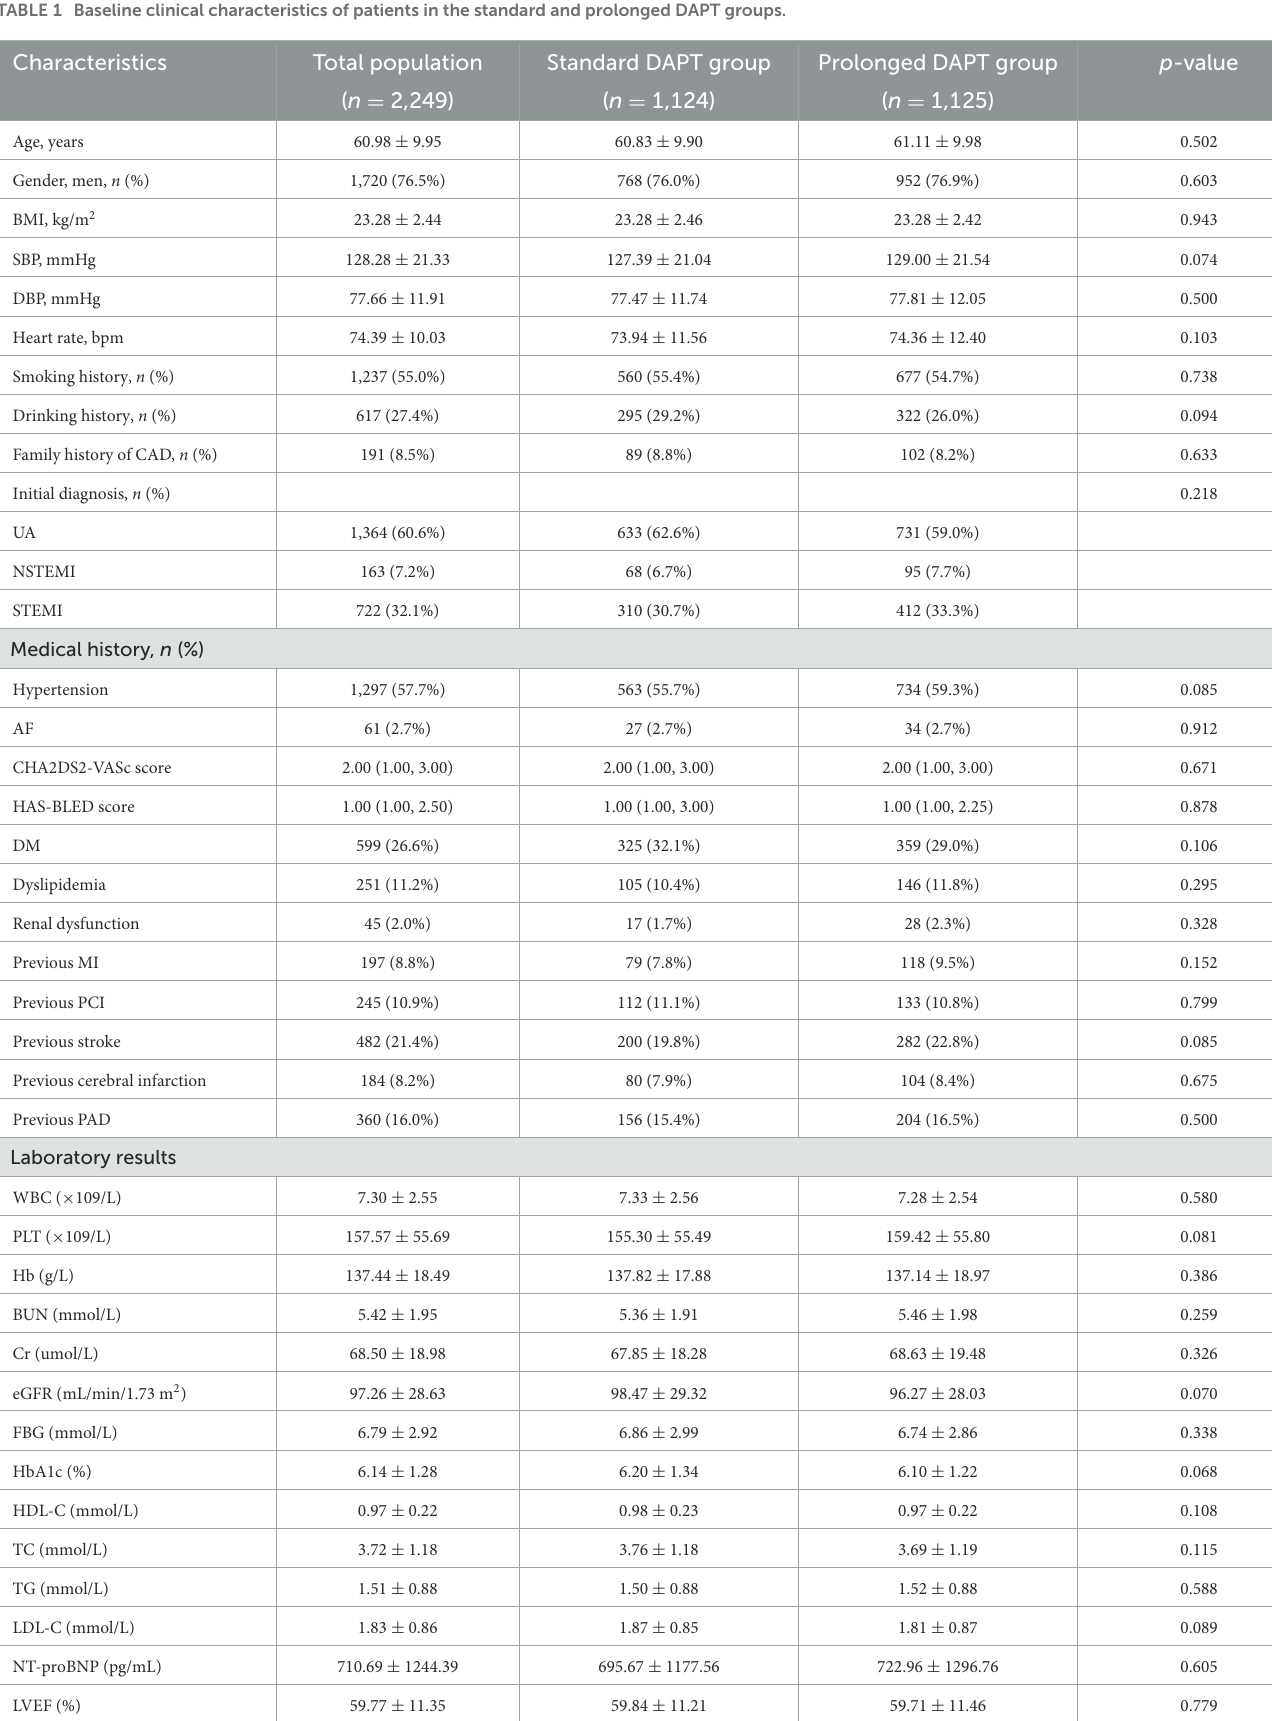
TABLE 1 Baseline clinical characteristics of patients in the standard and prolonged DAPT